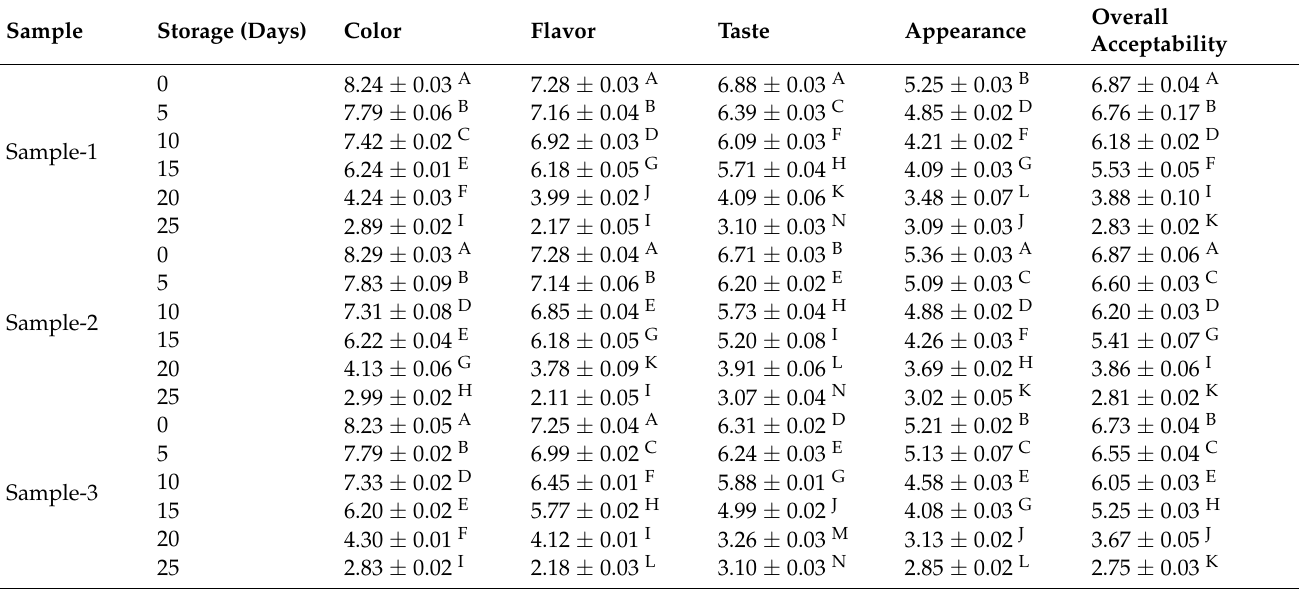
Table 5. Sensory analysis of whey-mango based mixed beverage during storage 1